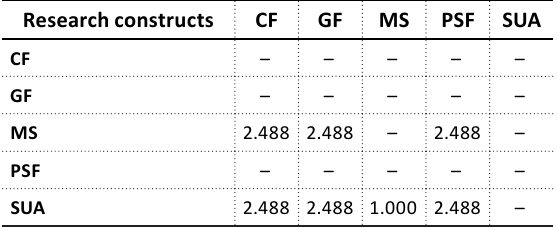
Table 6. VIF results in the structural model